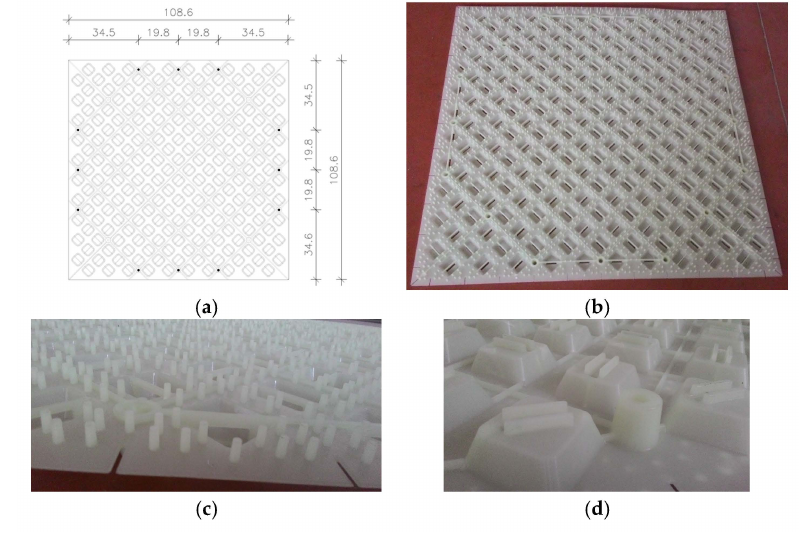
Figure 2. Technoprene slab (skin): ( a ) Geometry (cm) and fixing points; ( b ) Front view; ( c ) Front view in detail; and ( d ) Back view in